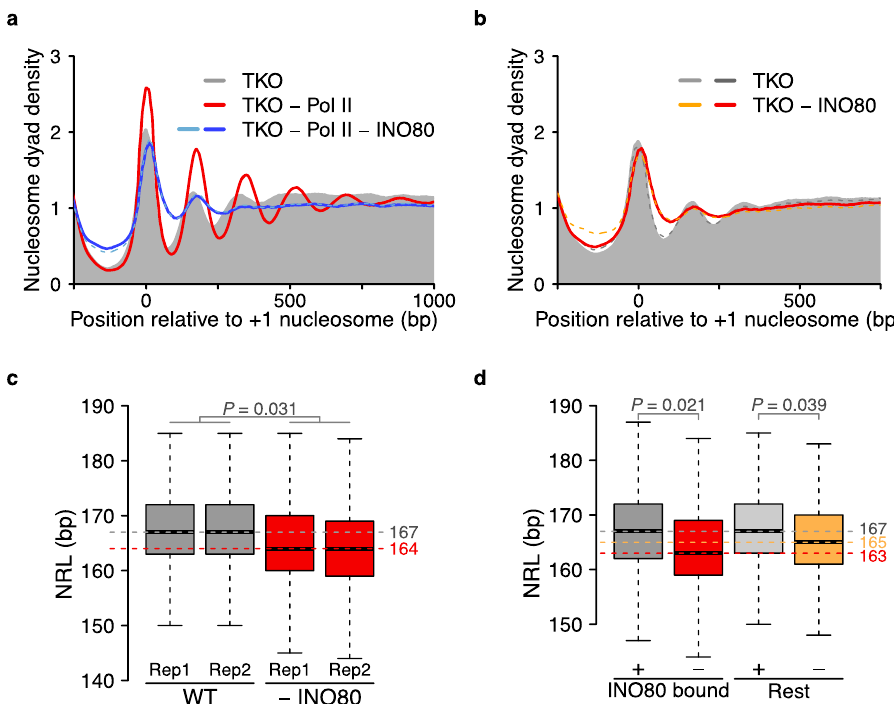
Fig. 3 INO80 induces nucleosome array formation in vivo. a Nucleosome organization for the indicated Pol II anchor-away strains. Samples were treated with vehicle (TKO) or rapamycin (all other samples) for 2 h, twice as long as in Fig. 2. The treatment regimen allowed for ef fi cient depletion, as tested by live cell imaging of GFP-tagged INO80 and Rbp3 ChIP-qPCR (Supplementary Figs. 2a and 4a). Dashed line: biological replicate. b Nucleosome organization upon INO80 depletion (1.5 h) in TKO cells (red and orange). Ino80-GFP-FRB tagged TKO cells treated with vehicle served as the reference (grey). Live cell imaging con fi rmed INO80 depletion (Supplementary Fig. 4d). c NRL distribution before and after INO80 depletion (1.5 h) in WT cells. Median values are indicated with horizontal dashed lines. d NRLs of 1646 genes bound by INO80, as measured by ChEC-seq 3 . Bound genes have median value (red dashed line) that is 2 bp shorter of that of all other genes (orange dashed line) after depletion. P -values ( P ) in c , d represent statistical analyses performed with two-tailed Welch ’ s t -test on the mean values of two replicates. Central lines in box plots indicate the median, the box shows the interquartile range, and whiskers indicate data points within 1.5 times of the interquartile